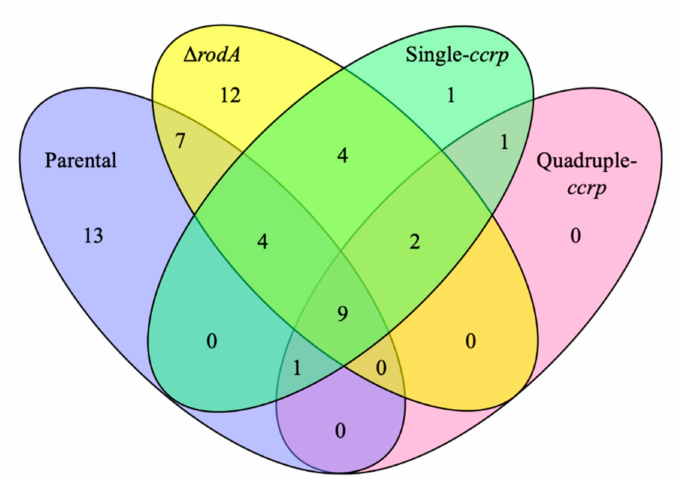
Figure 4. Four-ways Venn-diagram showing the number of proteins identified in the extract after subjecting the parental strain, ∆ rodA and ccrp-mutant dormant conidia to a brief trypsin digestion followed by proteomic analysis of the extracted proteins using LC-MS / MS. There were 34, 38, 22, and 13 proteins identified in the parental strain, ∆ rodA , single and quadruple ccrp-mutant conidial extracts, respectively. Of the total number of proteins extracted, the single ccrp-mutant showed 64% and 28% of similarity and the quadruple ccrp-mutant showed 77% and 15% similarity with the parental strain and ∆ rodA ,